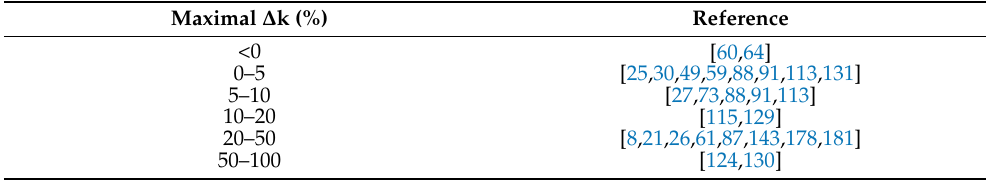
Table 13. Maximal thermal conductivity variation in oil-based cooling nanofluids with respect to the base fluid.